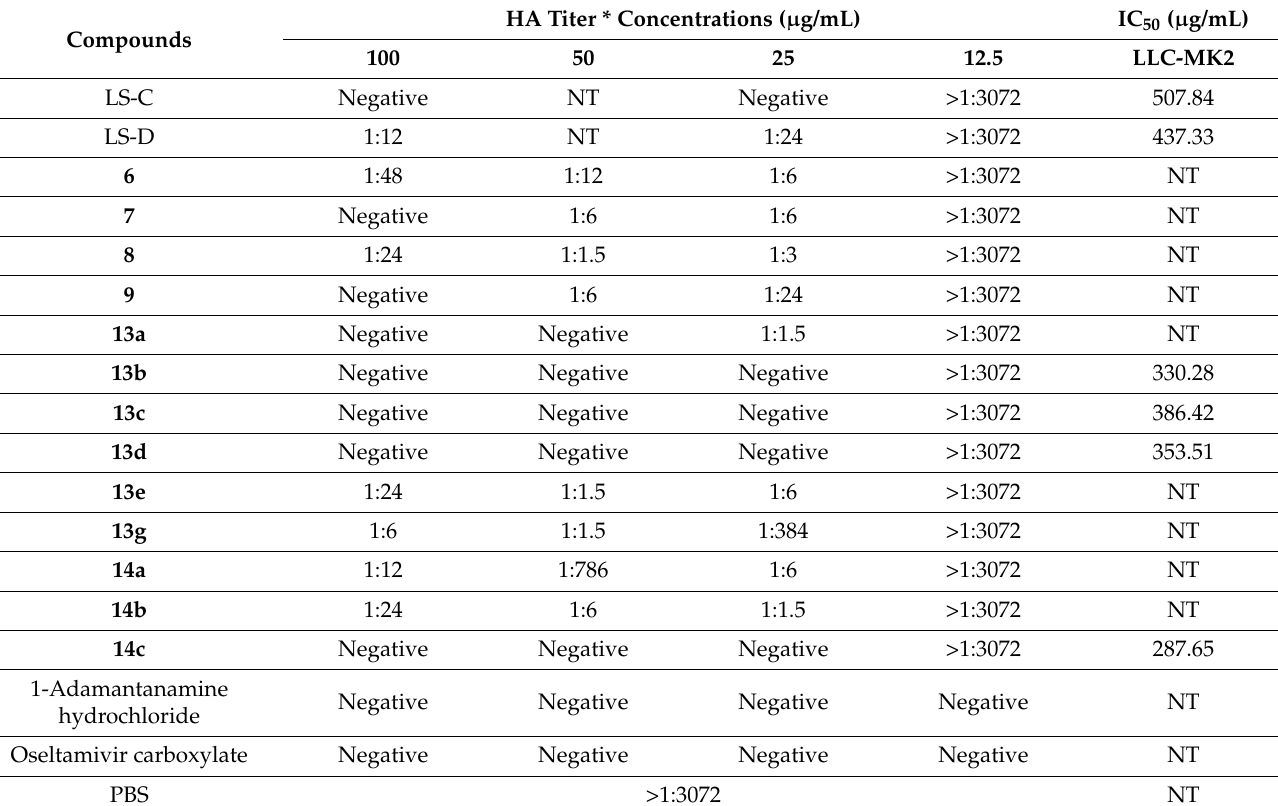
Table 1. Summary of influenza virus (H5N2) propagation inhibition in embryonated chicken eggs of LS-C, LS-D, and 2,5-DKP derivatives detected by hemagglutination assay and the cytotoxicity activity (IC 50 ) against